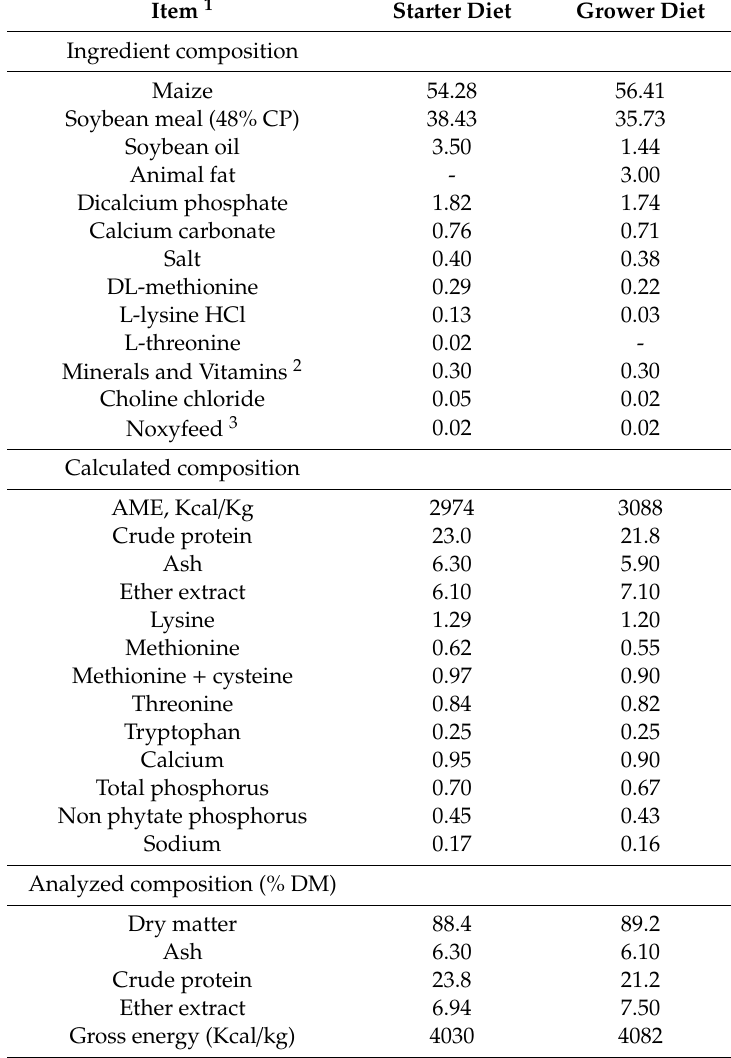
Table 1. Composition of starter experimental diets (%, as fed basis, unless otherwise indicated) of experimental